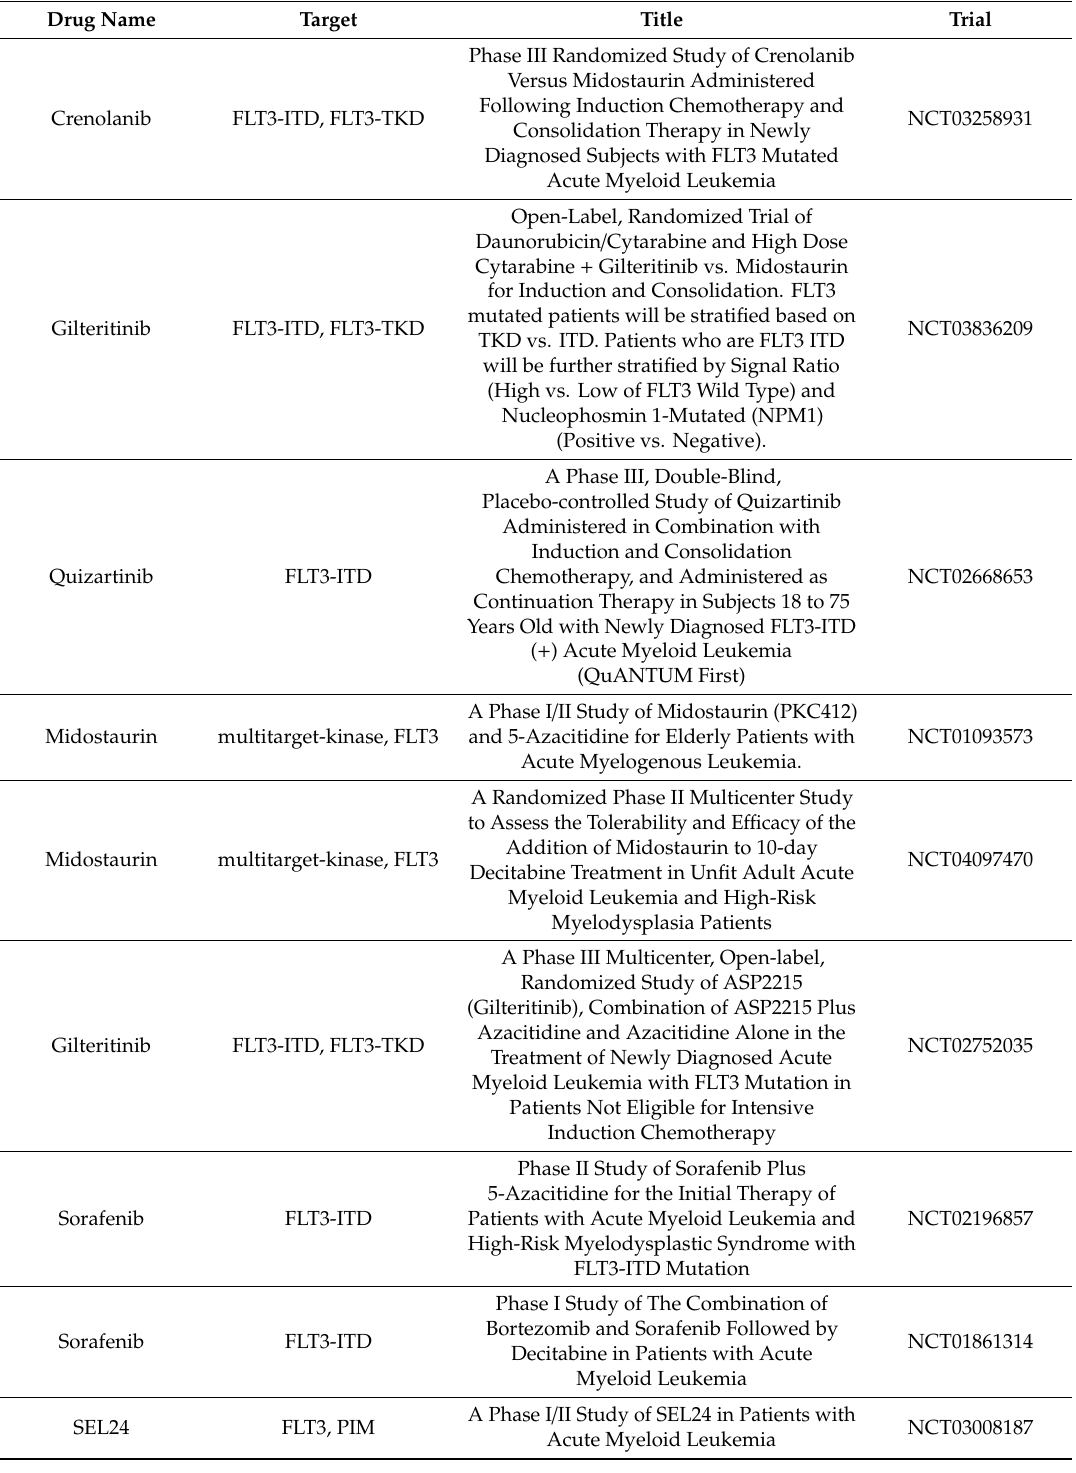
Table 2. Drugs in the Pipeline Newly Diagnosed AML /